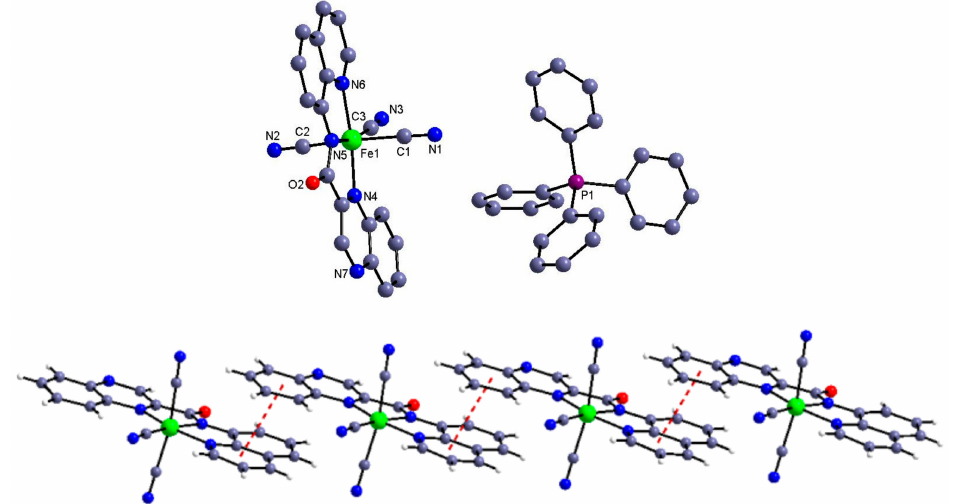
Figure 1. Molecular view of 1 with the selected atom-labeling scheme ( top ) and the one-dimensional supramolecular structure resulted from the intermolecular π – π interaction ( bottom ). The solvent water molecule has been omitted for